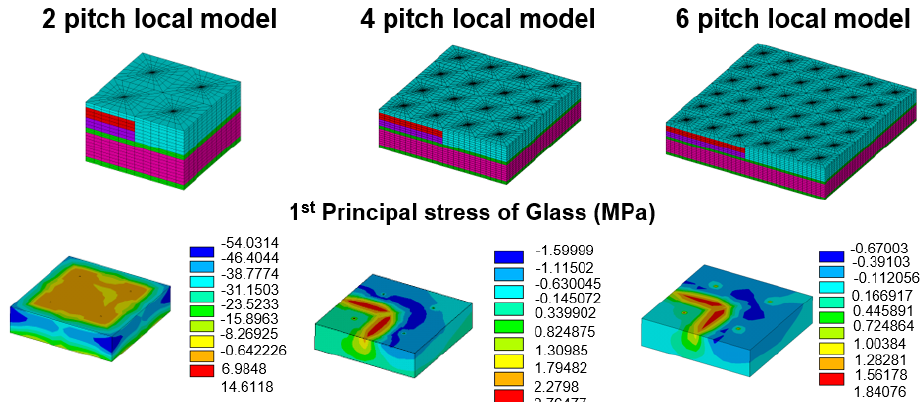
Figure 5. Numerical convergence analysis of the FEA submodeling local model with different via pitch amounts and the corresponding first principal stress distribution.